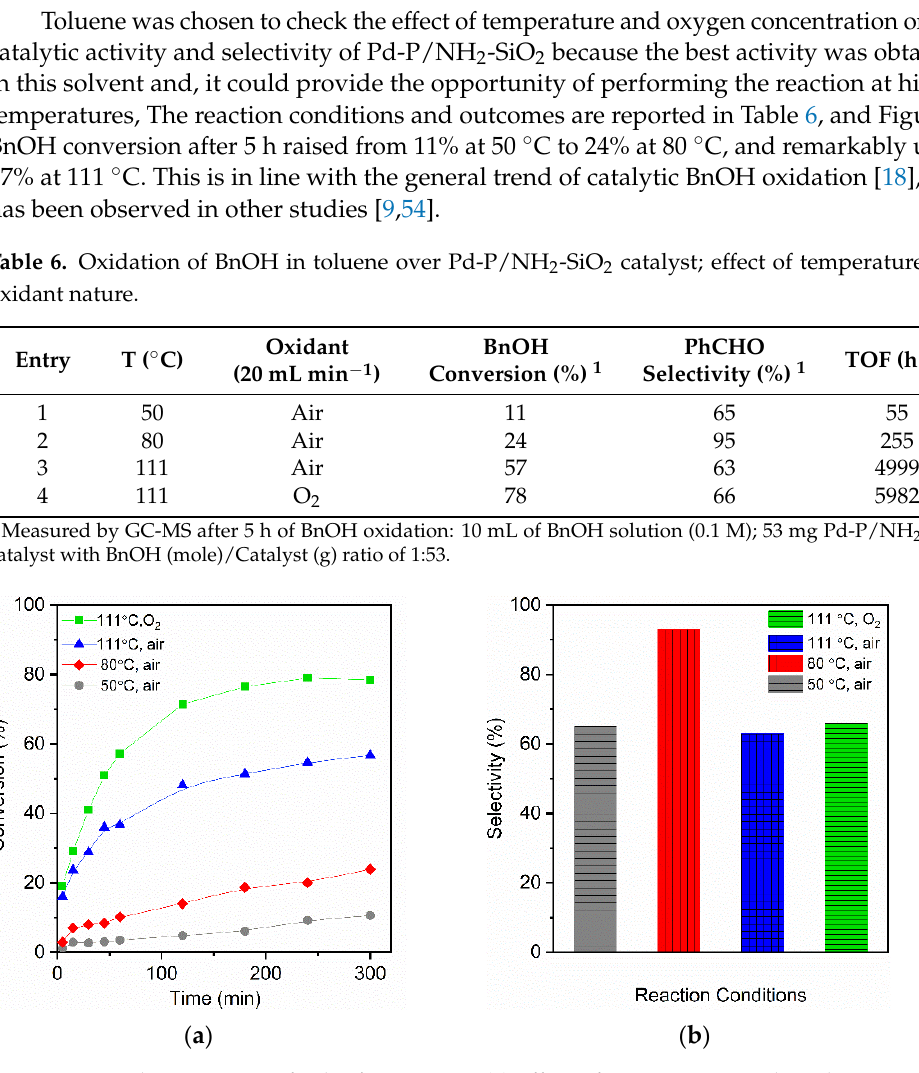
Figure 7. Catalytic activity of Pd-P/NH 2 -SiO 2 : ( a ) effect of temperature and oxidant on BnOH conversion over time, ( b ) PhCHO selectivity at 5 h. Reaction conditions: 10 mL BnOH (0.10 M) solution in toluene, 53 mg Pd-P/NH 2 -SiO 2 and 20 mL min − 1 oxidant flow rate.